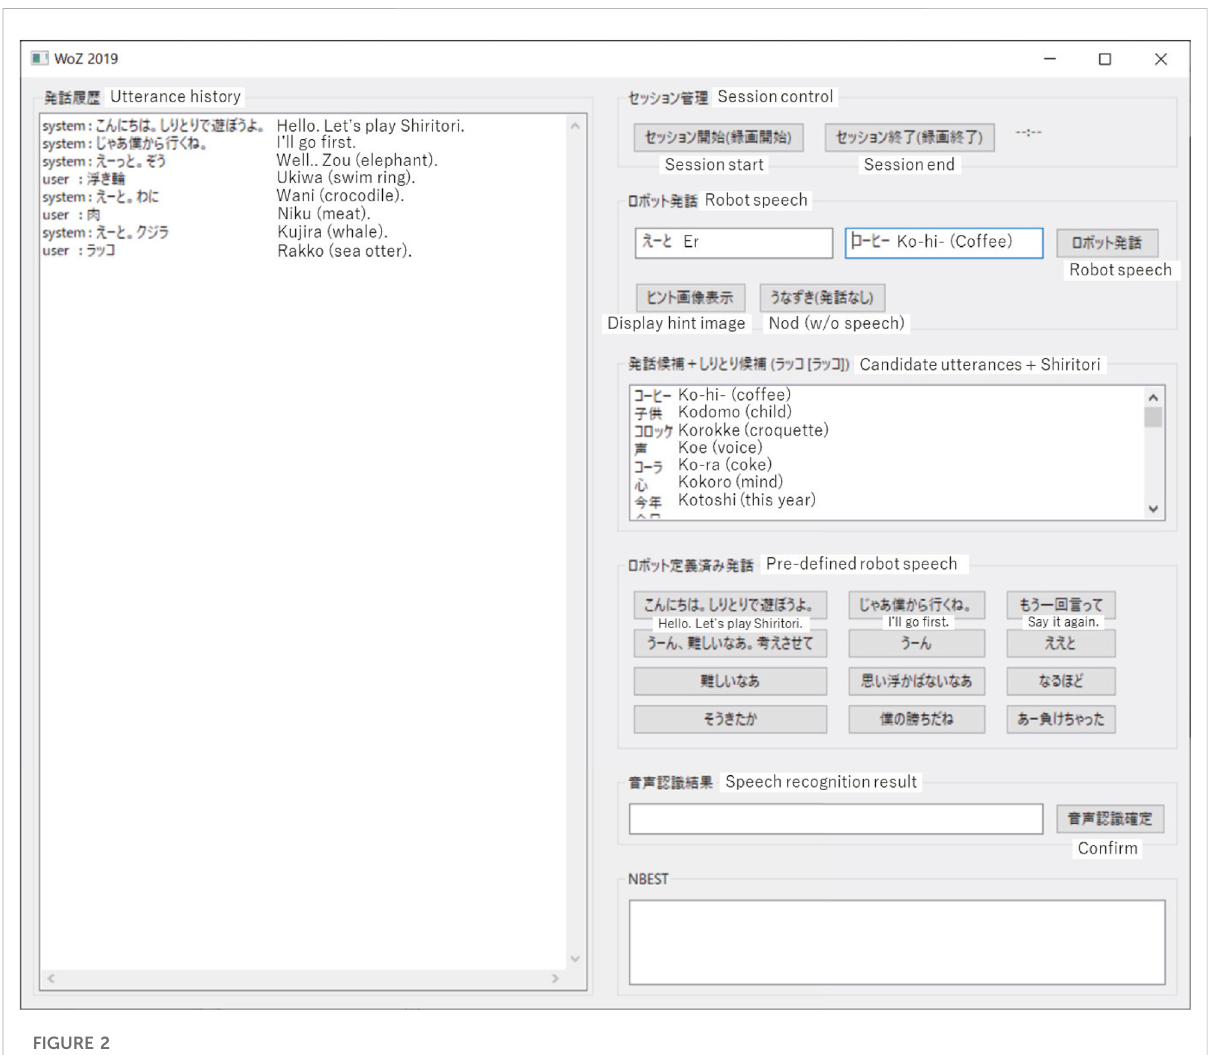
FIGURE 2 Screenshot of WOZ system